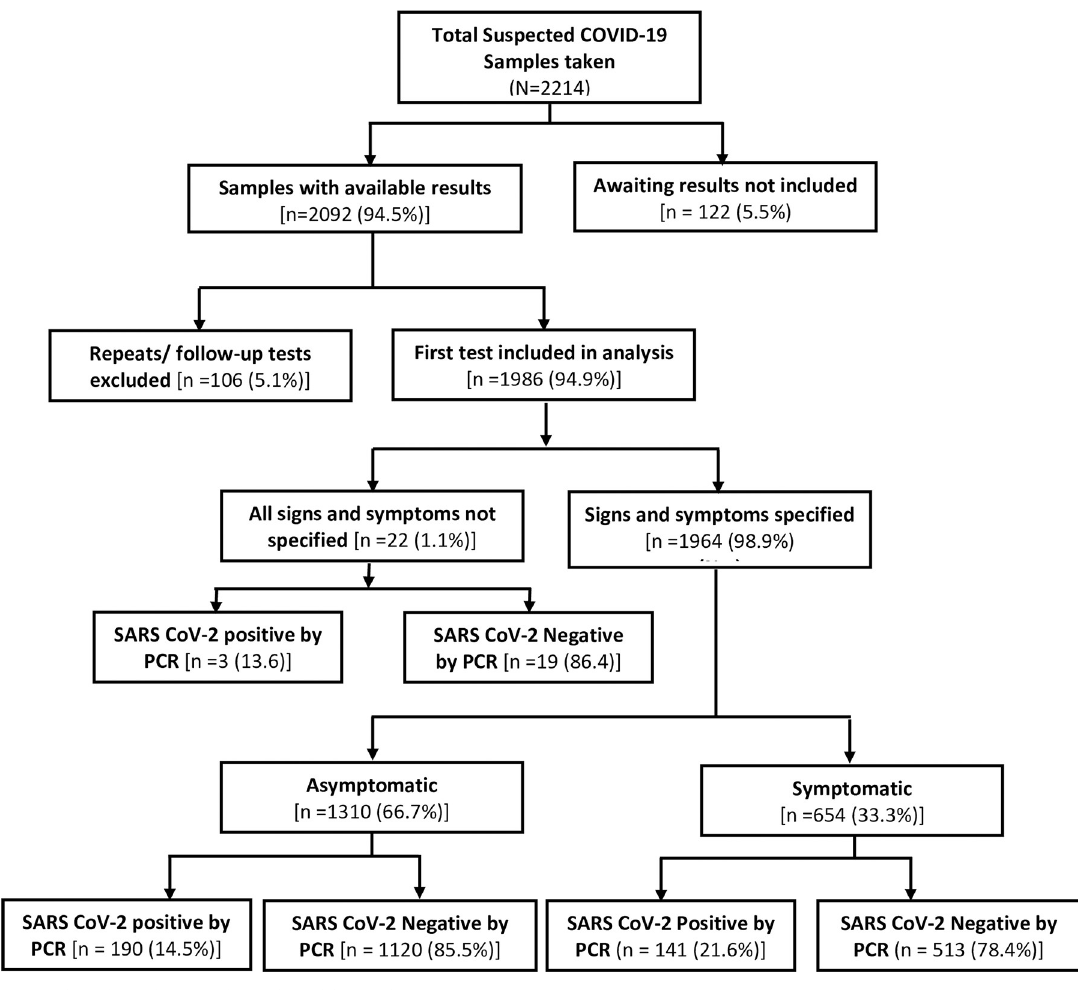
Fig 2. Flow chart showing data selected for analysis. was considered a candidate for inclusion in a multiple logistic regression if the p-value was less than 0.05 in the univariate logistic regression. Fever and sore throat were considered a-priori as independent factor and were eligible for inclusion irrespective of their p-value. The multiple logistic regression was carried out adjusting for age, sex and history of travel outside the coun- try within the last fourteen days. Variables whose p-value were less than 0.05 in the multiple logistic regression were included in the receiver operator characteristic (ROC) analysis. The ROC analysis reported sensitivity, specificity, area under curve, likelihood ratio positive and likelihood ratio negative. ROC curve of sensitivity versus 1-specificity were plotted for all fac- tors. Traditionally, the area under a curve of a worthless test is 0.5 [36]. This means the test includes the point of 50% sensitivity and 50% specificity. Such a test has a diagnostic ability equivalent to flipping a coin [36]. This was used to make a decision on the usefulness of the symptoms-based screening as a tool for picking up SARS-CoV-2 infection. A screening test was deemed worthless if the area under the curve is around 0.5. The performance of a screen- ing test is deemed to be desirable if Area Under Curve (AUC) is 0.7 � AUC � 0.8, excellent if 0.8 < AUC � 0.9 and outstanding if AUC is > 90 [37]. Fig 2 is a flow chart showing data selected for analysis.